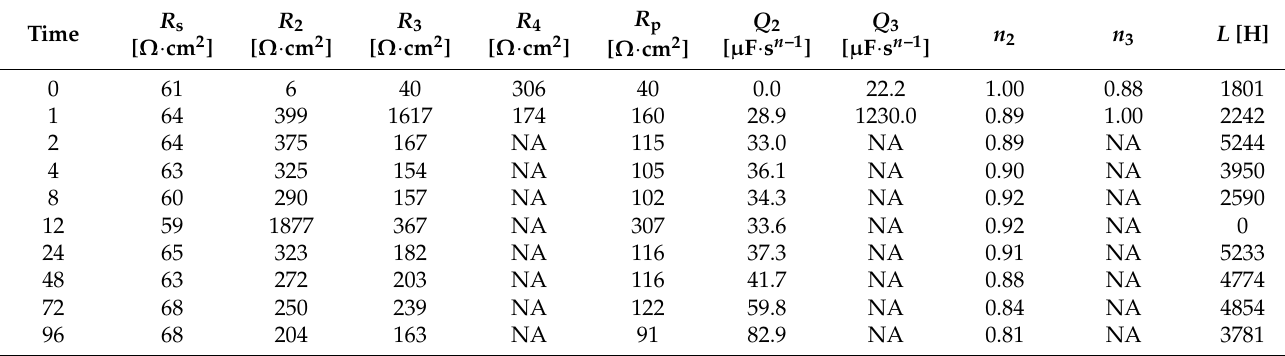
Table 4. Polarization resistance of pure Mg compacted at 500 MPa/400 ◦